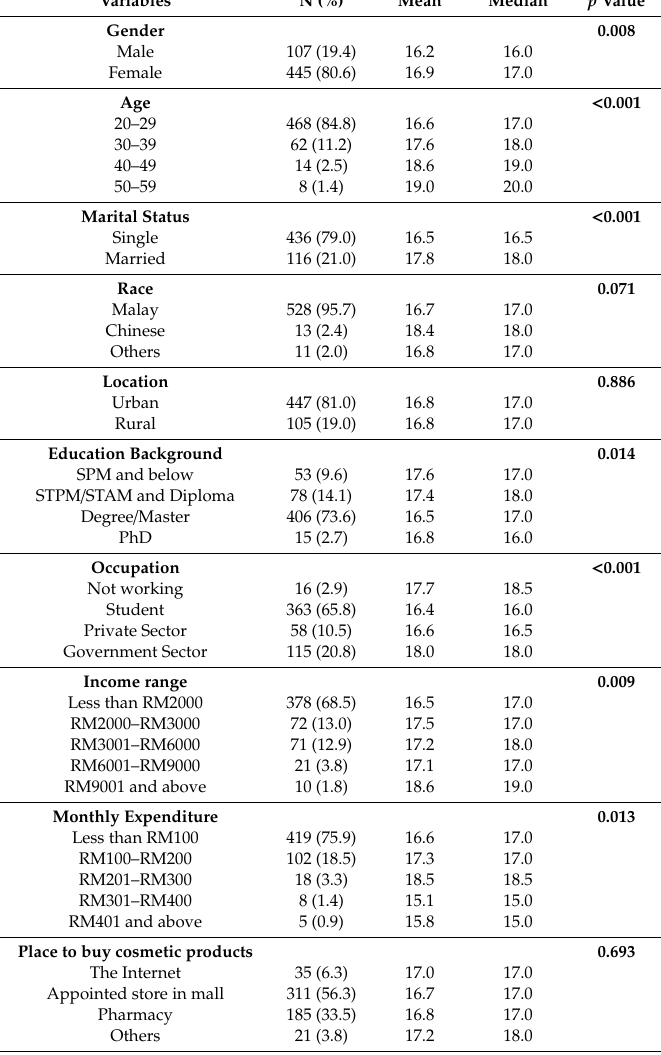
Table 6. Total attitude score di ff